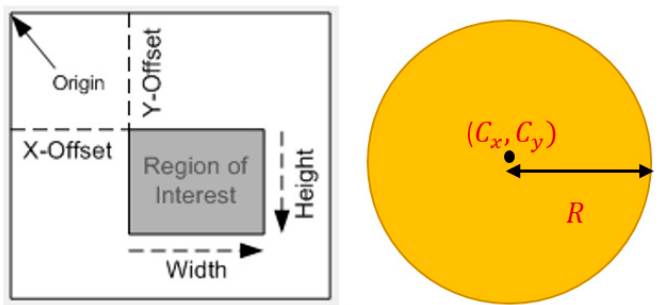
Figure 4. The size and position of the CRCHT window.